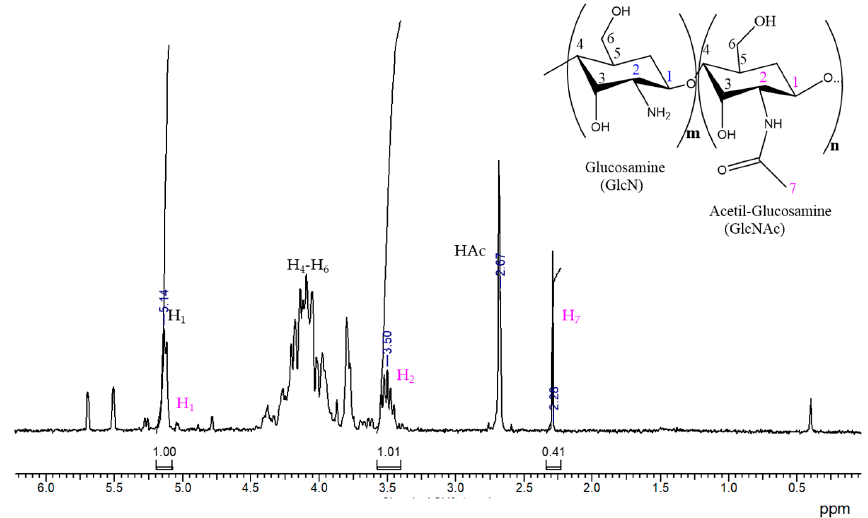
Figure 3. 1 H-NMR spectrum of chitosan in D 2 O/DCl at 30 °C. The degree of deacetylation ( DD ) of CS was calculated with Equation (3), using the integrations under the curve of the signal of H 1 (GlcN) and H 7 (GlcNAc), which gave us an 88% deacetylation degree of CS.